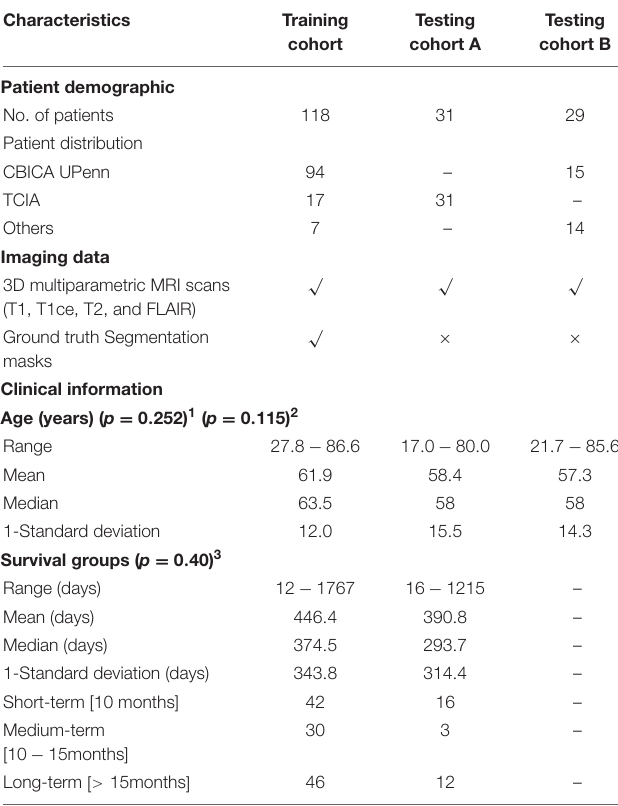
TABLE 1 | Summary of training and testing cohorts (A and B) used in the overall survival classification